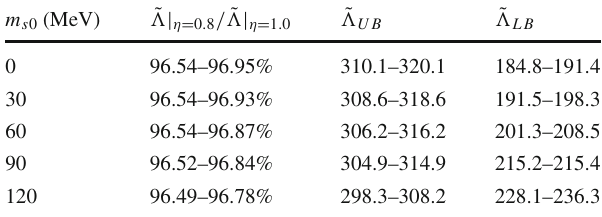
˜ (cid:2) mass ratio η = 0 . 7, while the lower panel shows the - M relations for the mass ratio η = 1 . 0. The black-dashed ˜ (cid:2) = horizontal line stands for 900, while the two black- dotted vertical lines stand for the chirp mass in the case